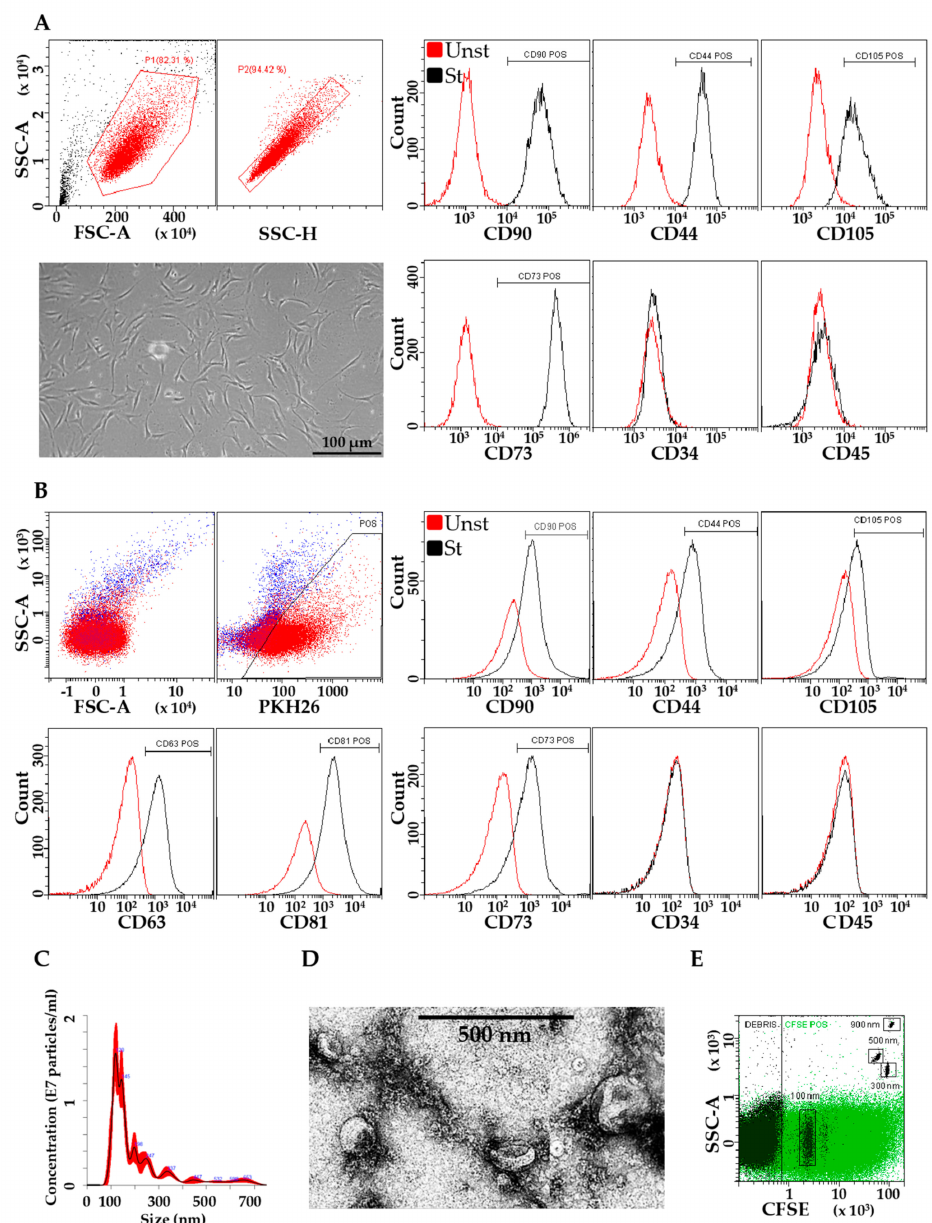
Figure 1. Characterization of ASCs and iASC-EVs. ( A ) Flow cytometry analysis shows the phenotypic resemblance of ASCs being positive to MSC markers (CD44 / 73 / 90 / 105) and negative to hemato / endothelial markers (CD34 / 45). ASCs also display typical fibroblast-like morphology. Representative cytograms are shown. ( B ) Flow cytometry analysis of iASC-EVs. EVs were stained with PKH26 to allow identification and gating of vesicles in PE channel (in red in the SSC vs. FSC and SSC vs. PE plots). Unstained EVs to set PE gating are shown in blue (SSC vs. FSC and SSC vs. PKH26 plots). After gating, PKH26 + iASC-EVs showed positivity to MSC markers and absence of hemato / endothelial ones. EVs are also positive for extracellular vesicle defining molecules CD63 and CD81. Representative cytograms are presented. ( C ) Size distribution of nanoparticles by NanoSight particle-tracking analysis. ( D ) Transmission electron micrographs of iASC-derived vesicles showing particles with characteristic cup-shaped morphology. ( E ) Cytogram of CFSE-labeled iASC-EVs confirming vesicle